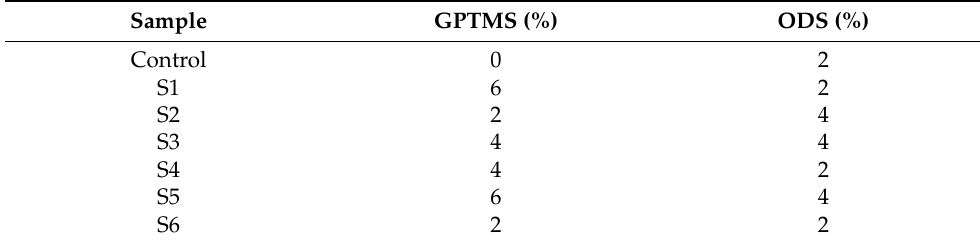
Table 1. Diverse amounts of GPTMS and ODS used to develop coated